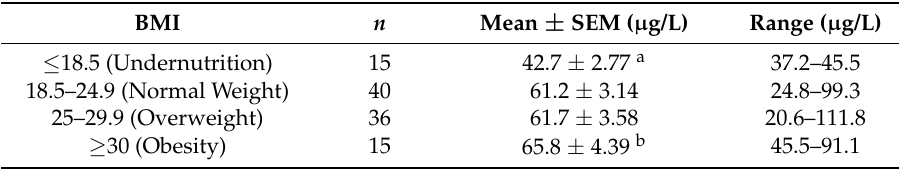
Table 9. Serum Se of IBD patients as a function of body mass index.